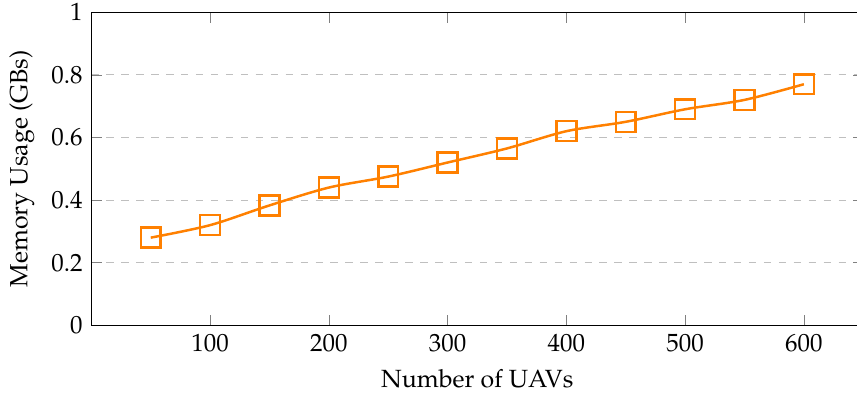
Figure 8. Memory utilization with increasing sensors.